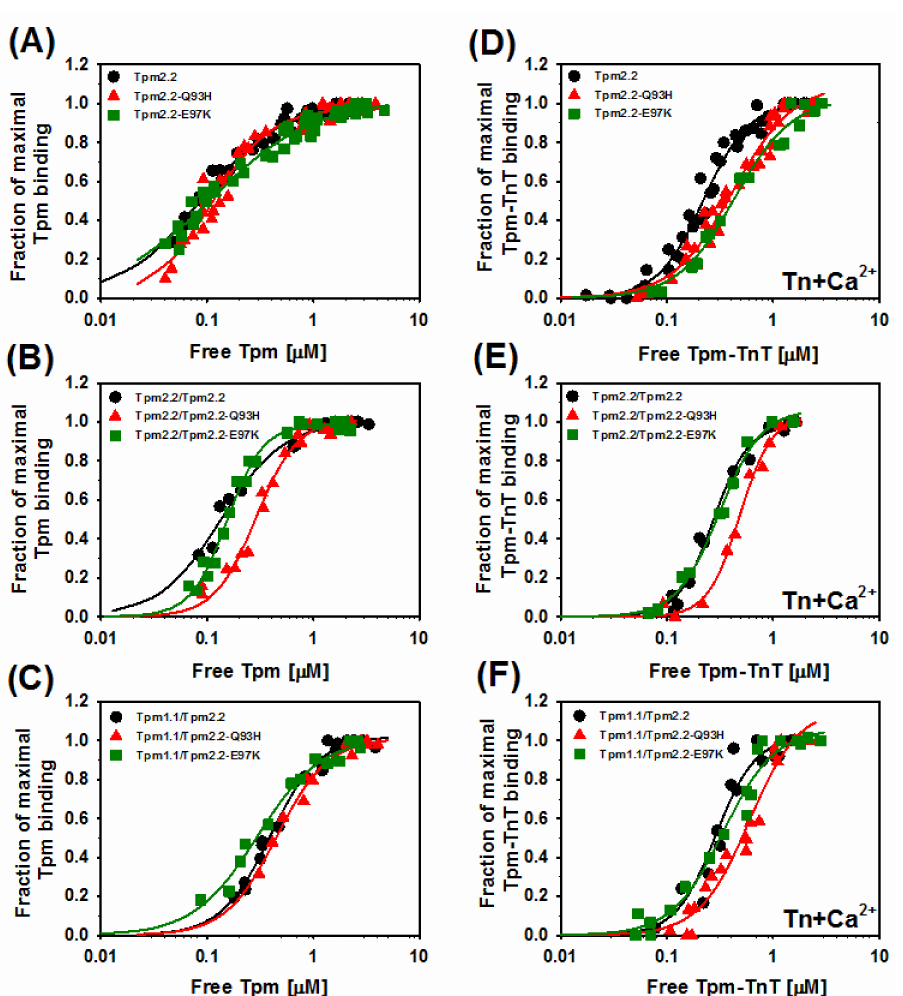
Figure 3. Effects of the substitutions Q93H and E97K in Tpm2.2 on tropomyosin binding to actin alone ( A – C ) and in the presence of troponin (Tn) ( D – F ). The symbols are: black circles, Tpm2.2; red triangles, Tpm2.2-Q93H; green squares, Tpm2.2-E97K. Conditions: 5 mM imidazole, pH 7.0, 2 mM MgCl 2 , 150 mM NaCl ( − Tn) or 300 mM NaCl (+Tn + Ca 2+ ). Protein concentrations and normalization method are described in Materials and Methods. Table 1. Binding parameters of Tpm2.2 homodimers and heterodimers to F-actin in the presence and absence of Tn (Ca 2+ ).